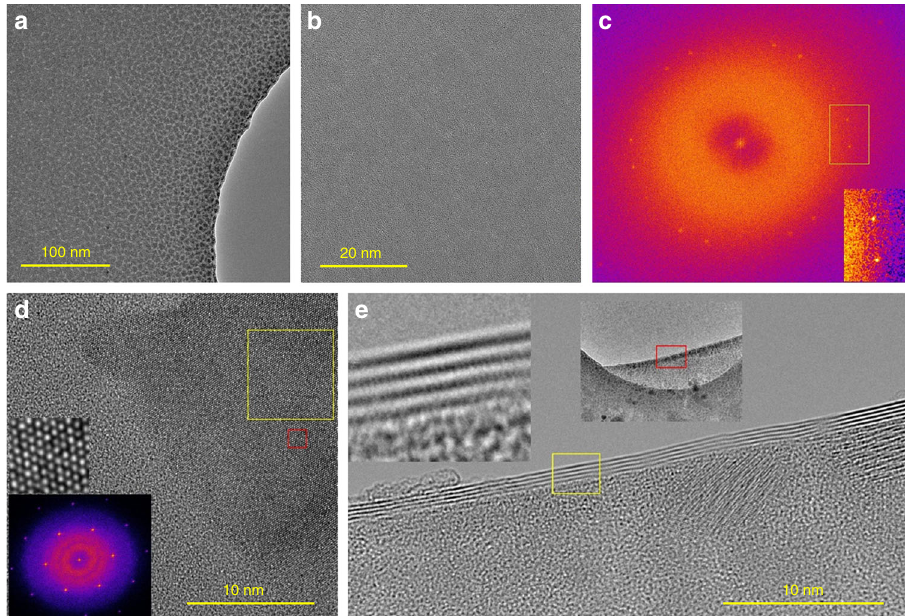
Fig. 3 In-situ TEM analysis of the crystallization process of Ge 2 Sb 2 Se 4 Te 1 (GSS4T1). a Low-magni fi cation and b higher-magni fi cation images of GSS4T1 fi lm on a SiN holder after heating at 400 °C for 5 min. c Local fast Fourier transformation (FFT) of b showing two sets of reciprocal lattice points, which reveals that the sample contains two sets of hexagonal re fl exes with a twist angle. d High-magni fi cation image of the fi lm after further annealing at 500 °C for 10 min. FFT analysis of the yellow square region shown in the inset indicates absence of the rotational stacking fault observed in b . e A back-folded region of the fi lm suspending over a hole in the SiN support (corresponding to the red rectangle in the inset), where the layered structure of hexagonal GSS4T1 is